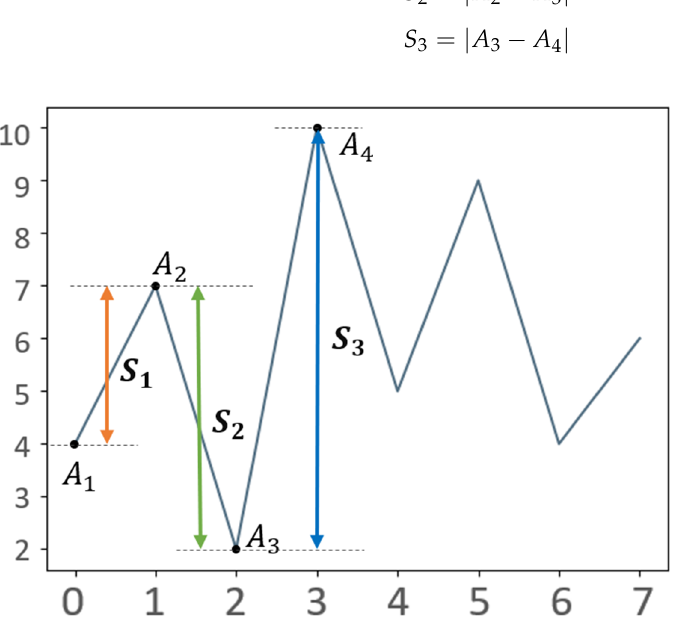
Figure 7. A schematic diagram for the four-point algorithm.